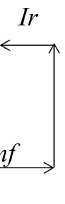
Figure 4. Assumed operating